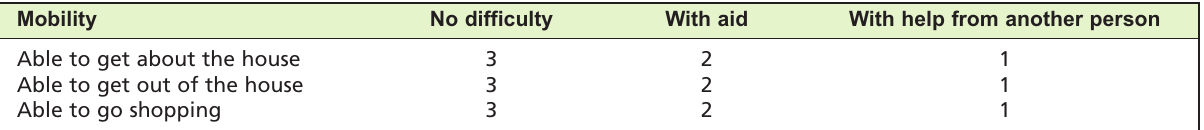
New mobility score (NMS) Table I: